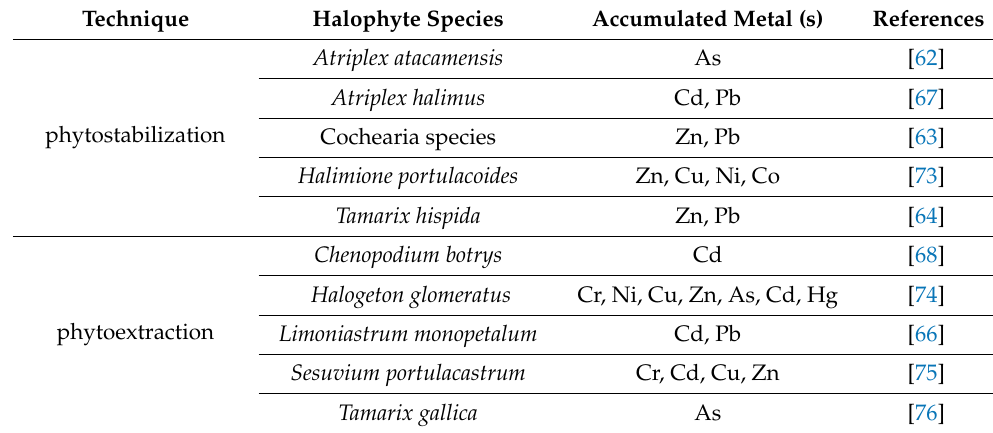
Table 1. Examples of the usefulness of halophytes in particular phytoremediation techniques for the removal of various metallic trace